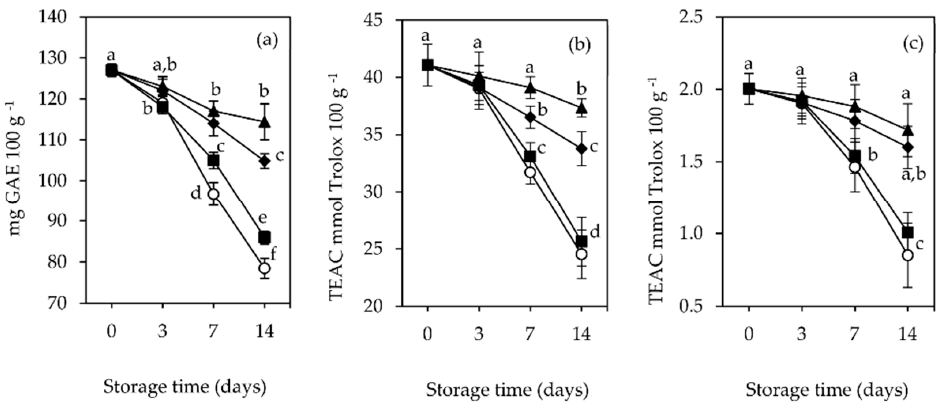
Figure 4. Total phenolic content ( a ) and antioxidant activity (AOA) [by DPPH ( b ) and FRAP ( c ) methods] of packaged raspberry ( Rubus idaeus L. cv. ‘Kweli’) fruits (no film-pad_Ctr ○ ; with film-pad containing green tea extract_Ch + GTE ◆ , rosemary extract_Ch + RSME ▲ , only chitosan ■ ), stored for 14 days at 4 °C under passive MAP conditions. Vertical bars indicate standard deviation of three replicates. TEAC: Trolox equivalent antioxidant capacity; GAE: gallic acid equivalents. Means with equal letters are not statistically different by Tukey’s test with 5% significance level.